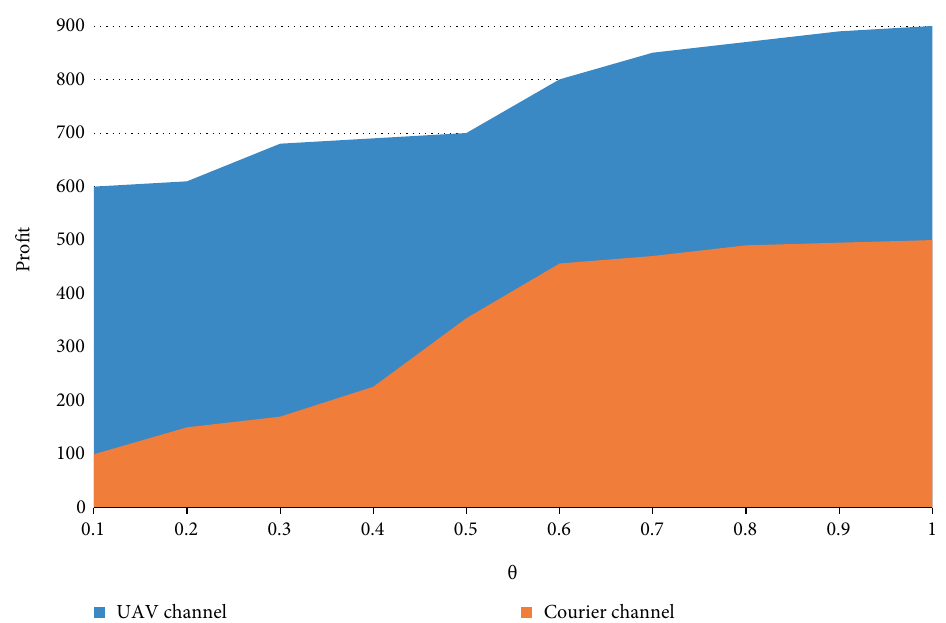
Figure 3: The impact of the market allocation proportion factor 𝜃 on the distribution quantity of UAV channels and courier channels.